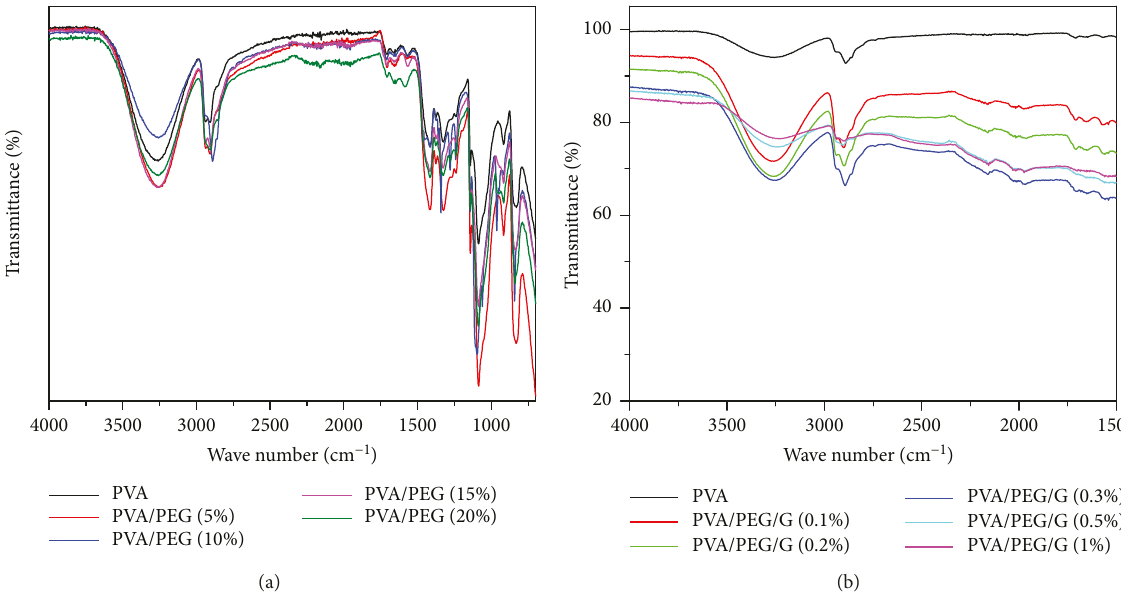
Figure 1: FTIR spectra for (a) PVA and its blends at di ff erent PEG loadings and (b) PVA/PEG nanocomposites at di ff erent graphene loadings.